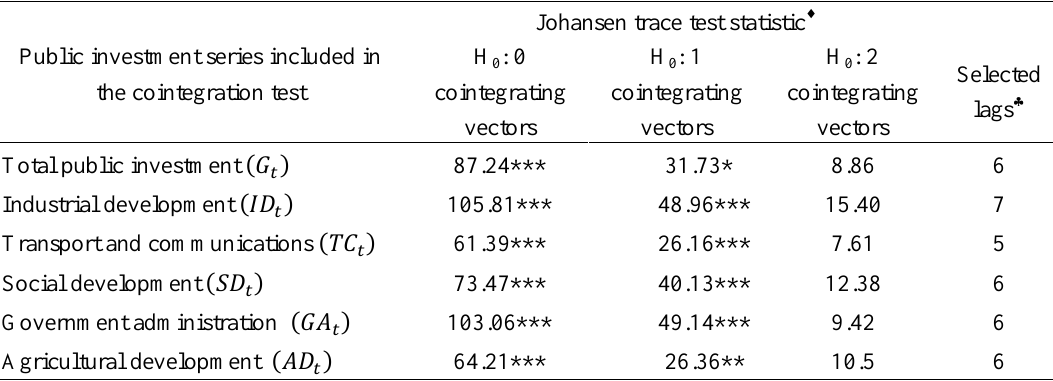
Table 2 : Results of the cointegration